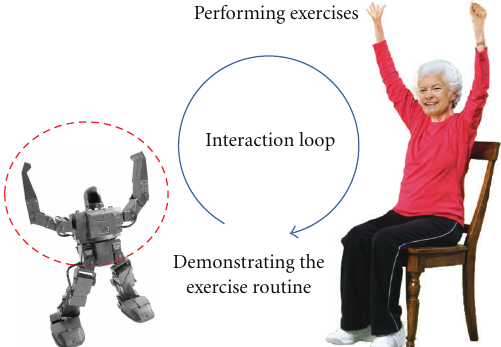
Figure 1: An interaction loop links the older adult user and the personal trainer robot. Within this loop, the robot leads the user through each exercise move by physically demonstrating it and giving encouragement and feedback on the user’s adherence through synthesized speech.